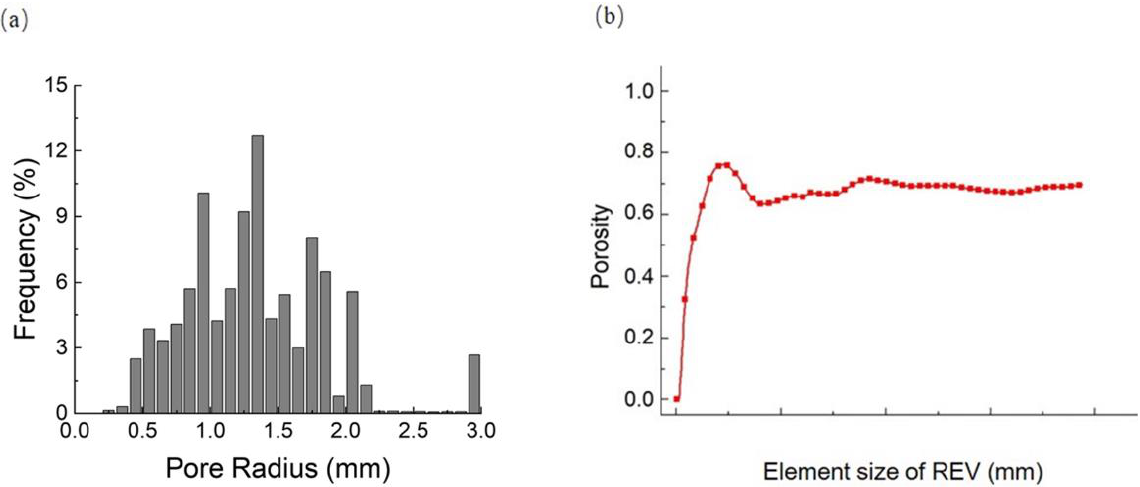
Figure 2. ( a ) The distribution of pore radius; ( b ) Porosity of REV.